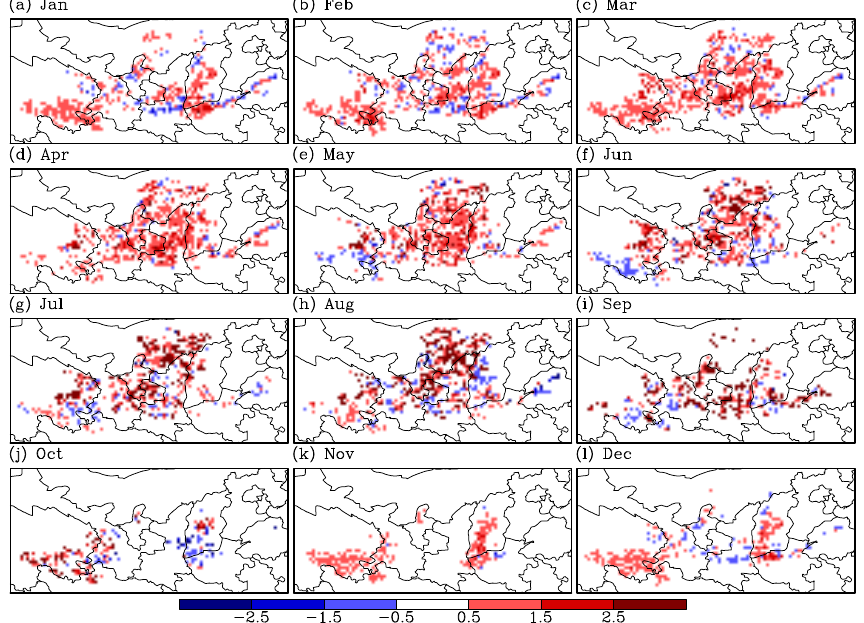
Figure 10. Differences in maximum lead times (months) between dry years (with soil moisture percentile lower than 20%) and the mean results for soil